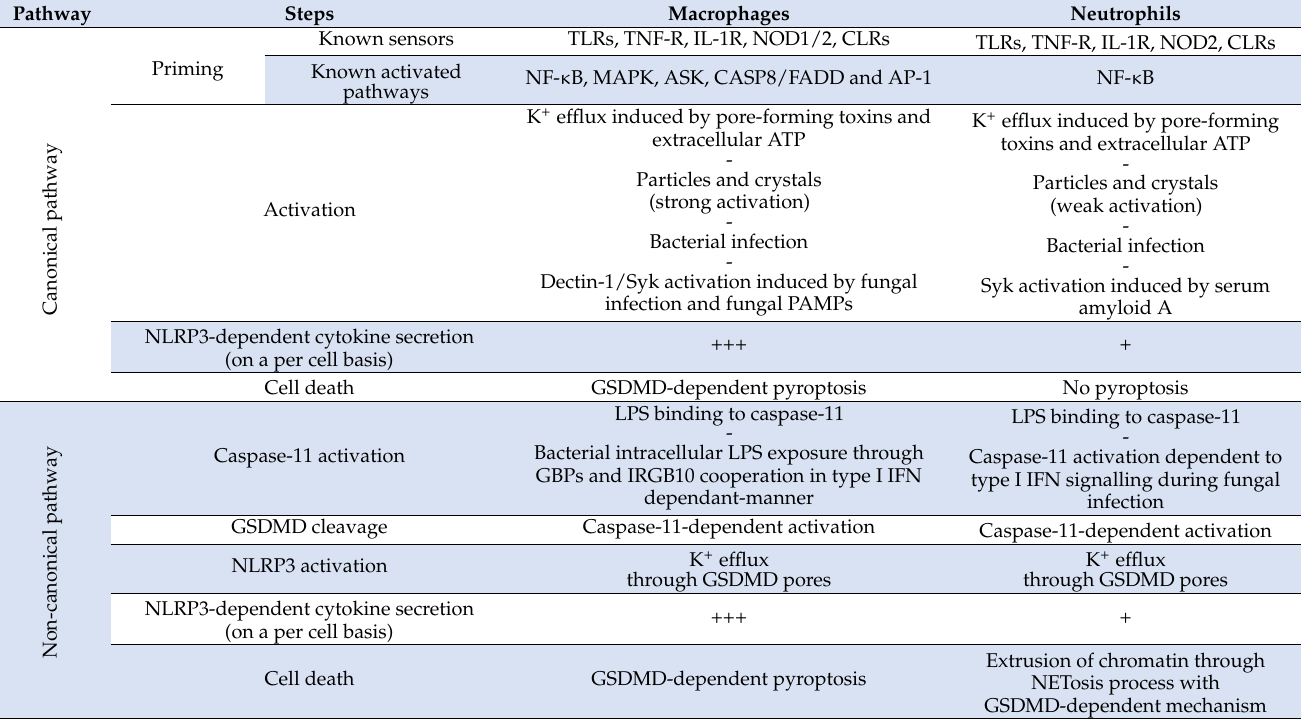
Table 1. Specific and conserved activation mechanisms of NLRP3 inflammasome and associated-cell death in macrophages vs. neutrophils. The table depicts only conditions in which mechanisms between macrophages and neutrophils have been compared. TLR, Toll-like receptors; TNF-R, tumor necrosis factor α receptor; IL-1R, interleukine-1 receptor; NOD, nucleotide-binding oligomerization domain; CLR, C-type lectin receptors; NF- κ B, Nuclear factor kappa B; MAPK, mitogen-activated protein kinase; ASK, apoptosis signal-regulating kinase; CASP8, caspase-8; FADD, FAS-associated death domain; AP-1, Activator protein 1; Syk, spleen tyrosine kinase; K, potassium; GSDMD, gasdermin D; CASP11, caspase-11; LPS, lipopolysaccharide; GBP, guanylate-binding proteins; IRGB10, immunity-related GTPase family member b10; IFN, interferon; NETosis, neutrophil extracellular